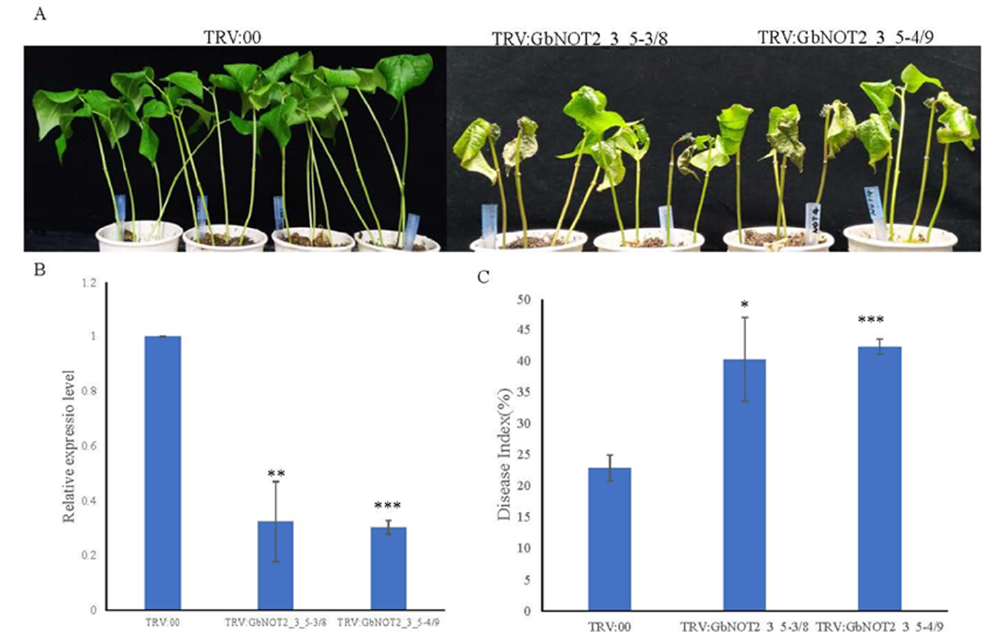
Figure 8. Silencing GbNOT2_3_5 genes reduced Verticillium wilt resistance in cotton. ( A ) The phenotypes of silencing plants and control after infection of V. dahlia . TRV:00 represented empty vector, TRV:GbNOT2_3_5 represented GbNOT2_3_5 genes silenced. ( B ) Expression levels of GbNOT2_3_5 genes in silencing plants and control. ( C ) The DI values of silencing plants and control after infection of V. dahlia . * p < 0.1 by Student ’s t test, ** p < 0.05 and *** p < 0.01